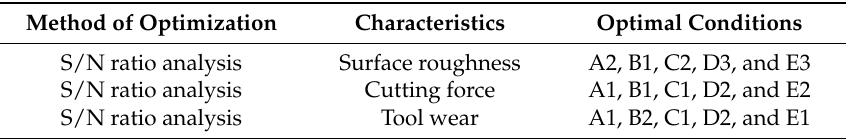
Table 11. Optimal setting of machining parameters.